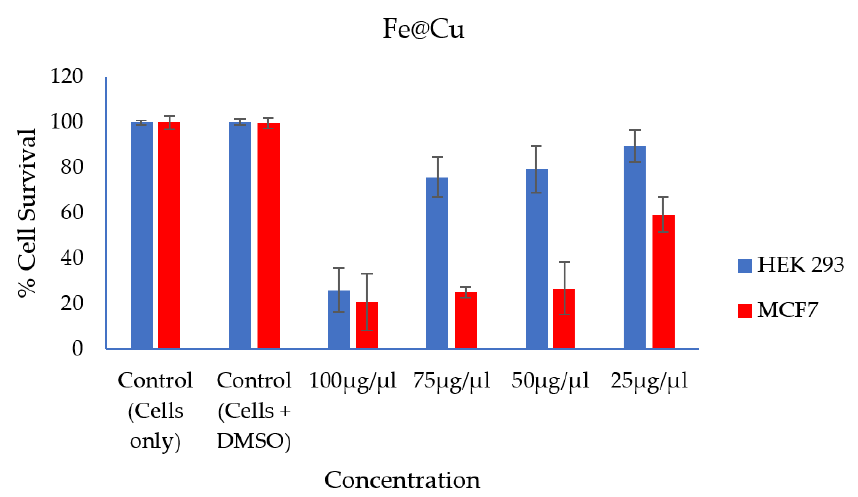
Figure 8. In-vitro cytotoxicity e ff ect of Fe@Cu nanoparticles on HEK293 and MCF7 cells.